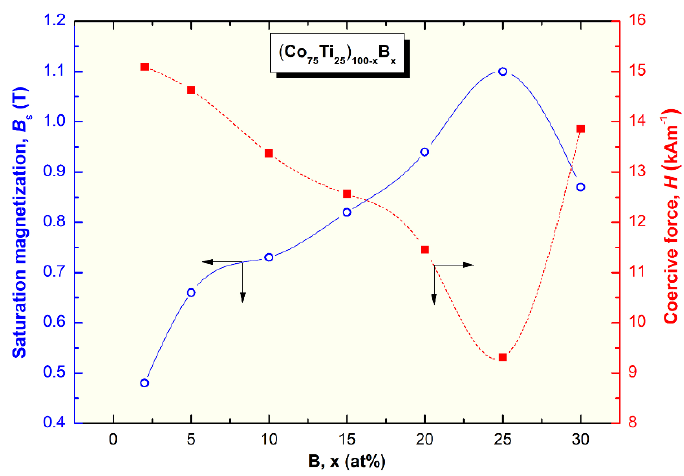
Figure 12. Effect of B content (x, at%) on the saturation magnetization and coercive force of (Co 75 Ti 25 ) 100−x B x metallic glassy systems.